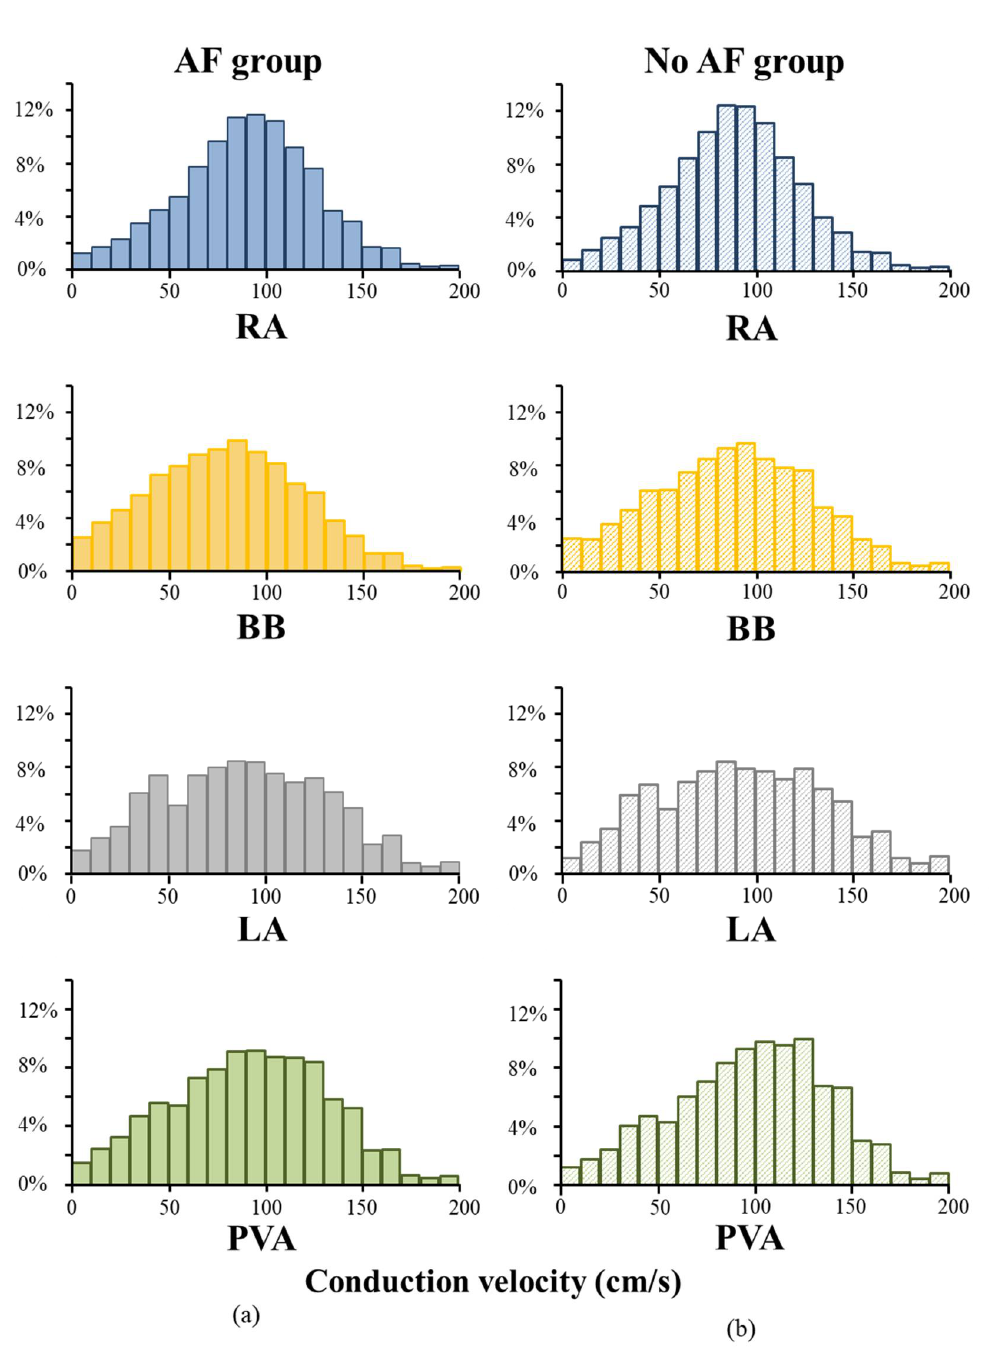
Figure 4. CV histograms of the AF and no AF group. Relative frequency distributions of CVs in the AF ( a ) and no AF group ( b ) shown for each location separately. cm/s = centimeter/second; AF = atrial fibrillation; BB = Bachmann’s Bundle; LA = left atrium; PVA = pulmonary vein area; RA = right atrium.